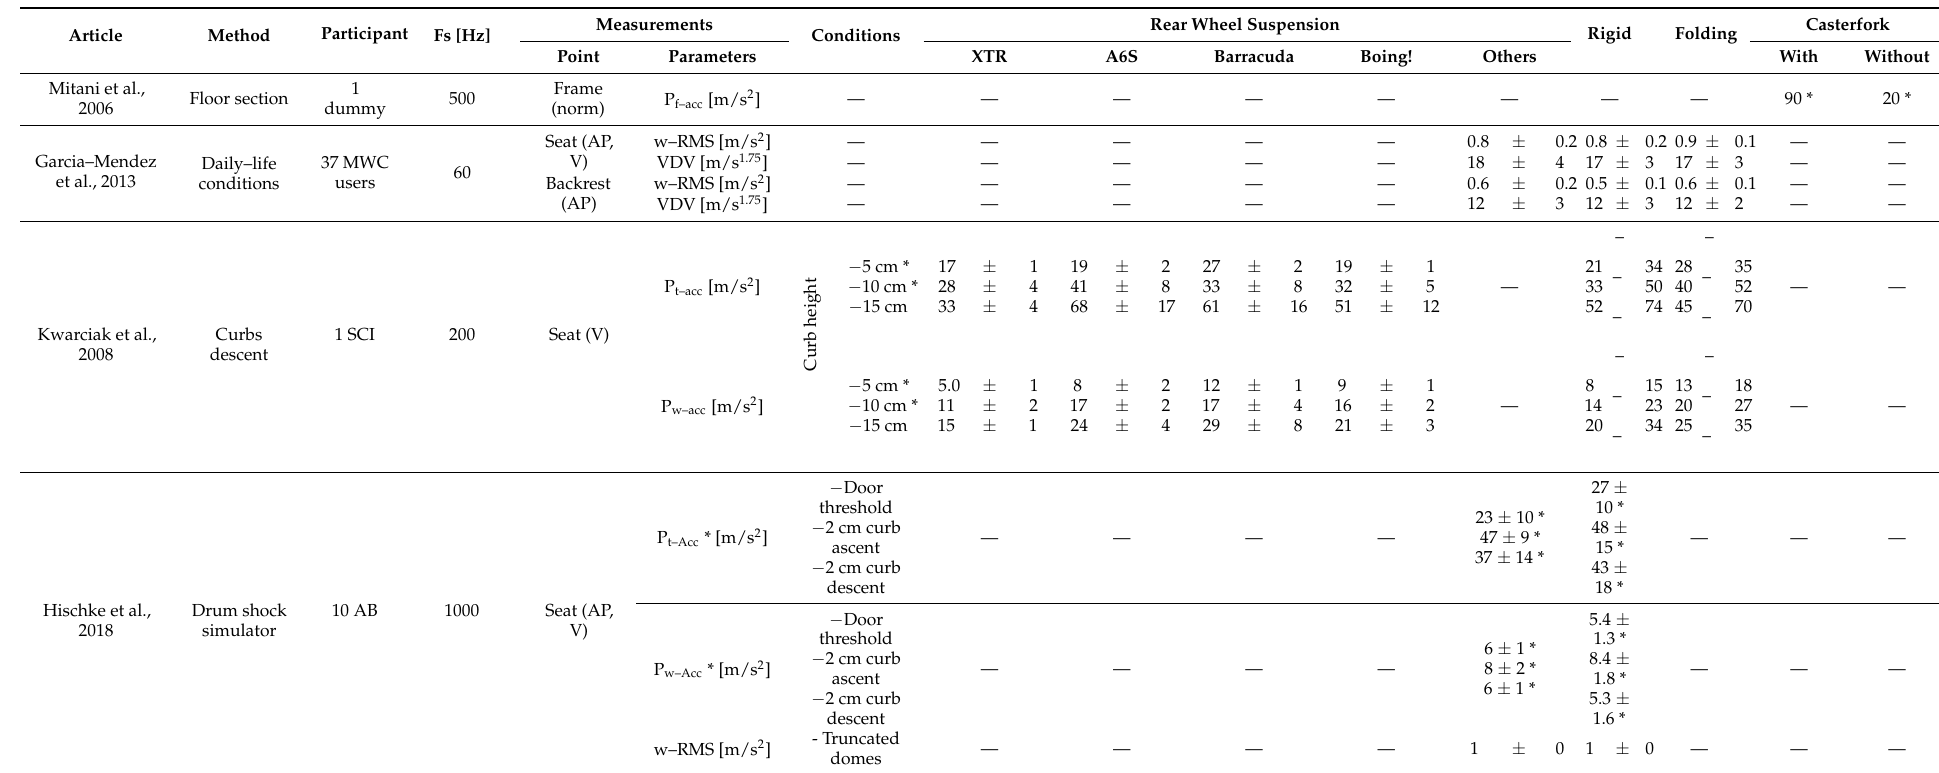
Table 8. Summary table of reviewed studies regarding the effect of suspensions on the vibration